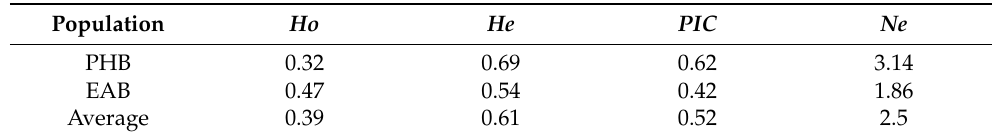
Table 3. Homozygosity, heterozygosity, polymorphism information contents and the number of effective alleles of ELA-DQAexon2 in two populations of Przewalski’s